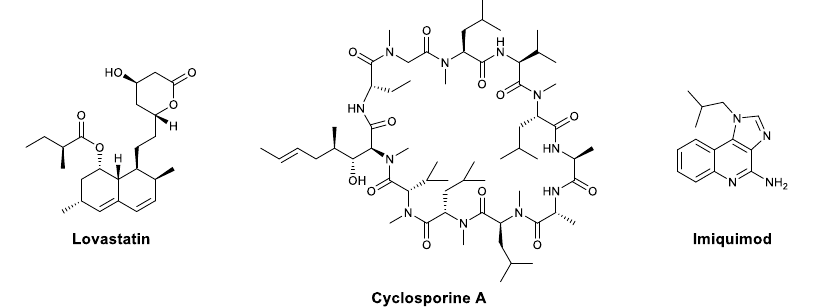
Figure 1. Structures of some broad-spectrum antiviral agents.